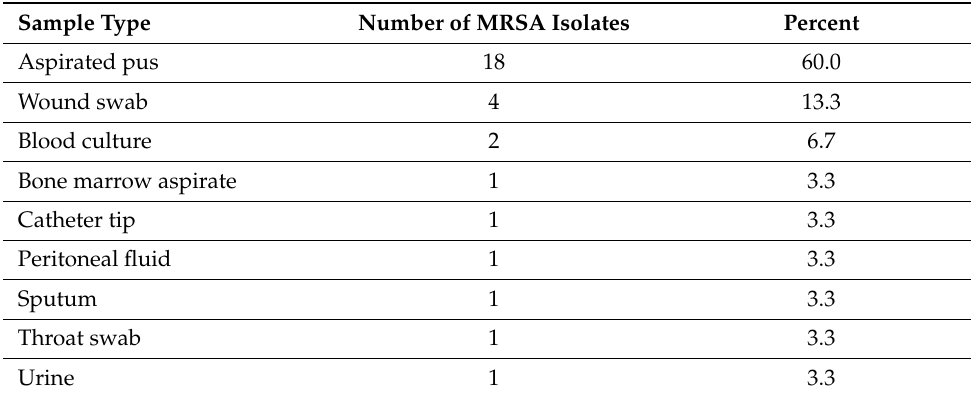
Table 1. Sample types and isolates.